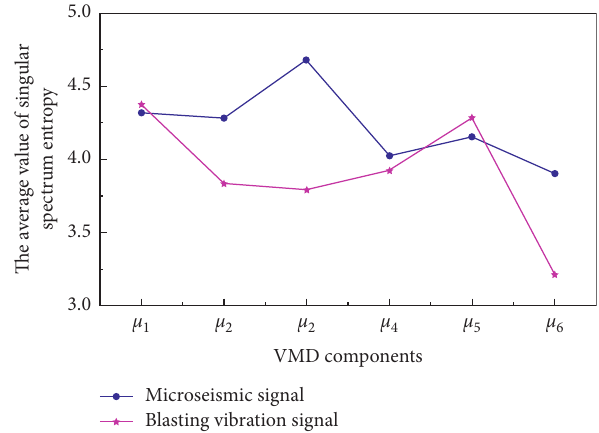
Figure 4: Multiscale singular spectrum entropy comparison chart of two kinds of